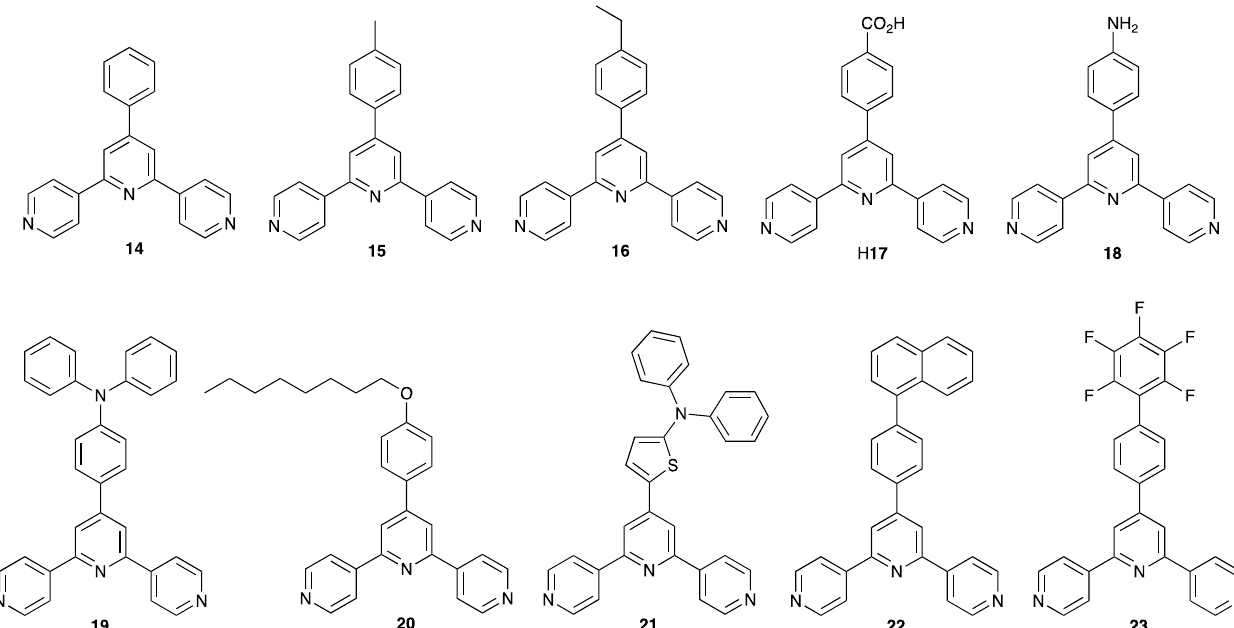
Scheme 6. Structures of 4’ ‐ functionalized 4,2’:6’,4” ‐ tpy ligands which form [Zn(4’ ‐ X ‐ 4,2’:6’,4” ‐ tpy)Cl 2 ] n 1D ‐ coordination polymers.